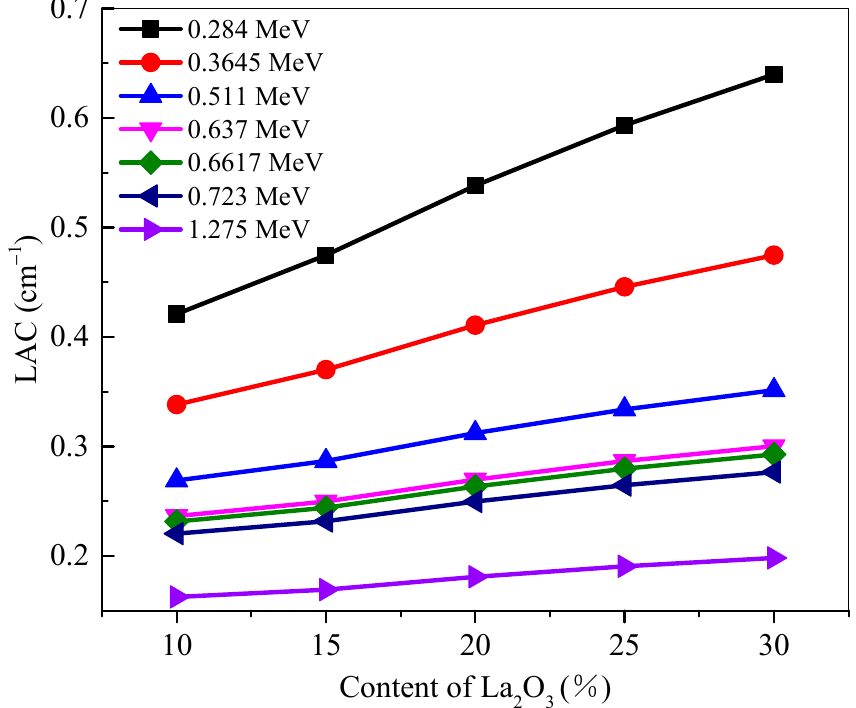
Figure 2. Effect of the content of La2O3 on the shielding performance for samples at 0.284, 0.3645, 0.511, 0.637, 0.6617, 0.723 and 1.275 MeV.